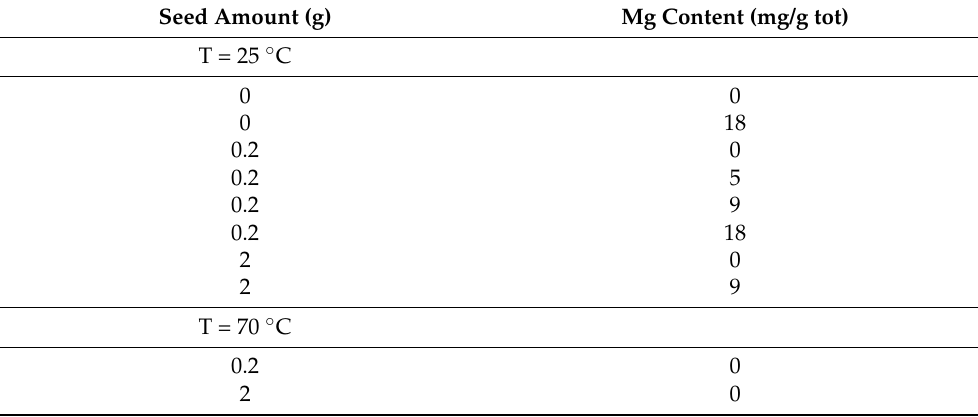
Figure 4. Temperature evolution during crystallization of nickel sulfate at temperatures 25 and 70 ◦ C. Seeds were added once the desired temperature was reached, where the arrows represent the seeding time points. The cooling rate for both cases is 0.29 ◦ C min − 1 . Note the temperature increase in the blue curve, showing the nucleation of nickel sulfate after seed addition. Table 1. Overview of experiments and their respective temperatures, seed amounts, and initial magnesium concentrations (mg Mg/g total solution) in the reactor solution.